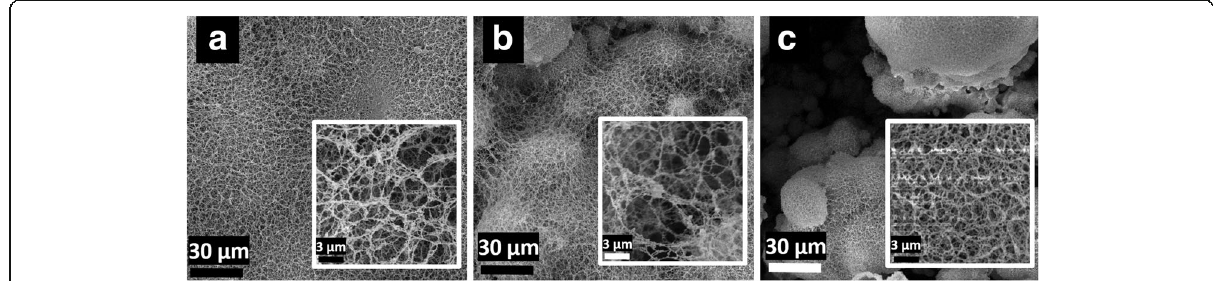
Fig. 3 SEM images of laser processed silicon at 0.025 mm line spacing. From left to right , the overlap changes from one, three, and five, respectively (the npannel within each image shows high magnification SEM